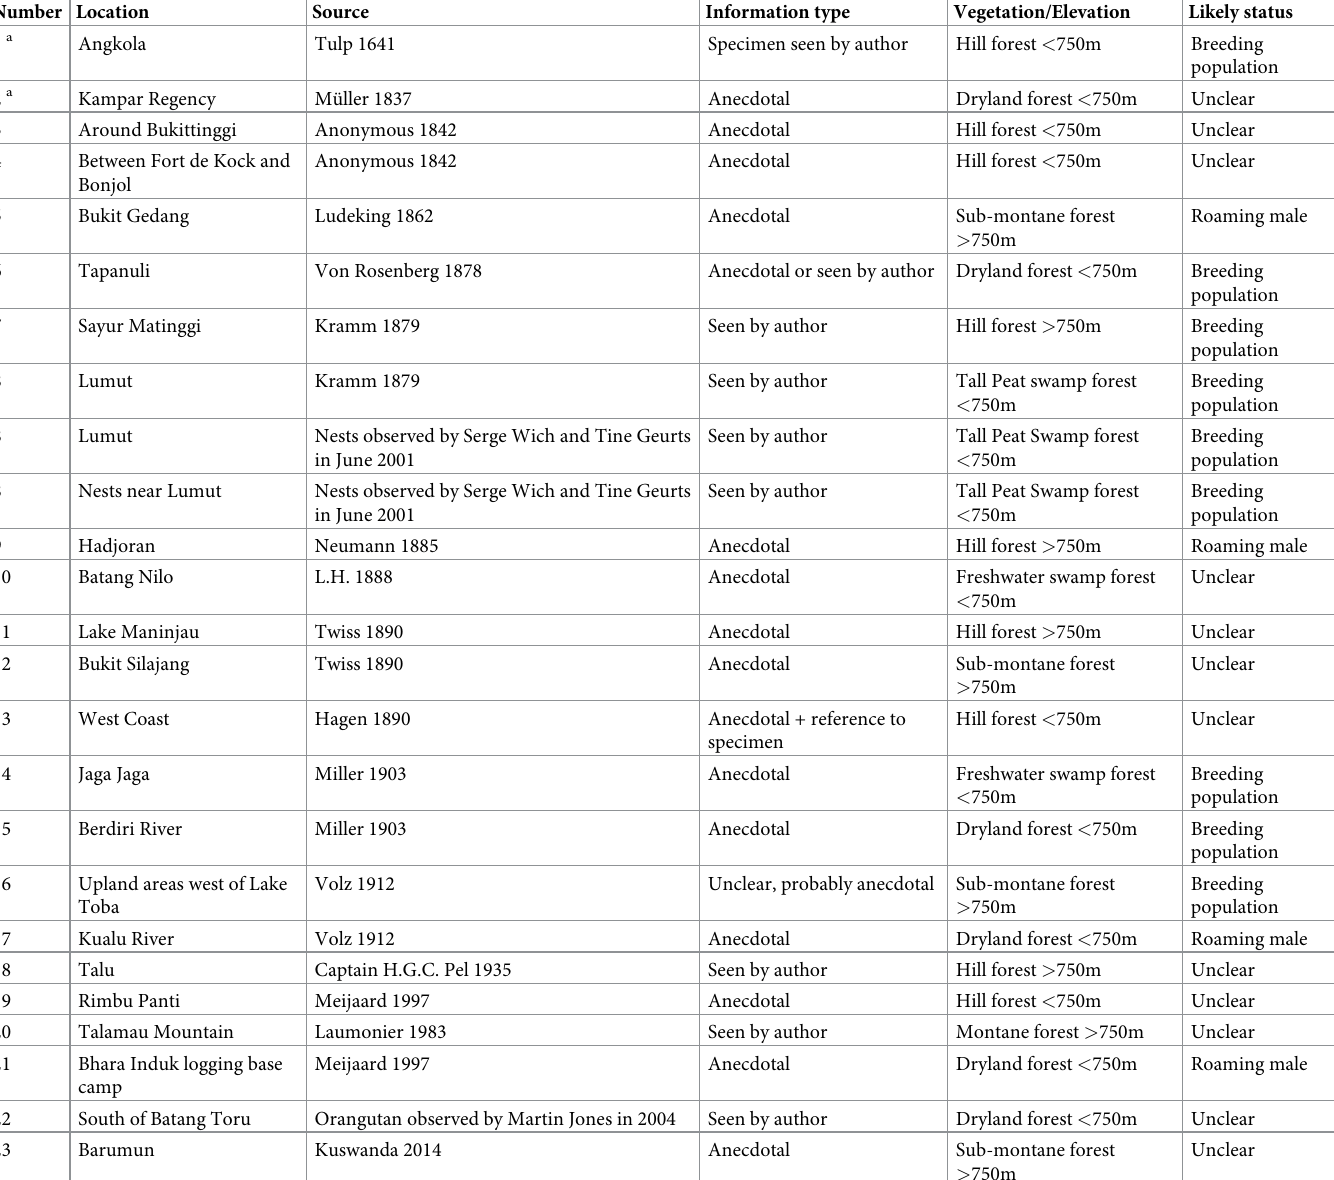
Table 1. Orangutan records, most likely P . tapanuliensis , but outside the current range, that we consider to be